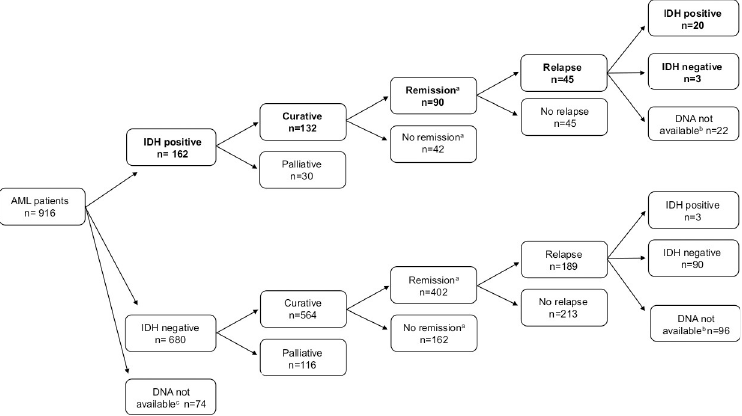
Fig 2. Clinical characteristics of IDH1 and IDH2 positive AML patients. a Remission was defined as morphologic leukemia-free state (MLFS) after induction. b DNA not available at relapse. c DNA not available at diagnosis for IDH1/2